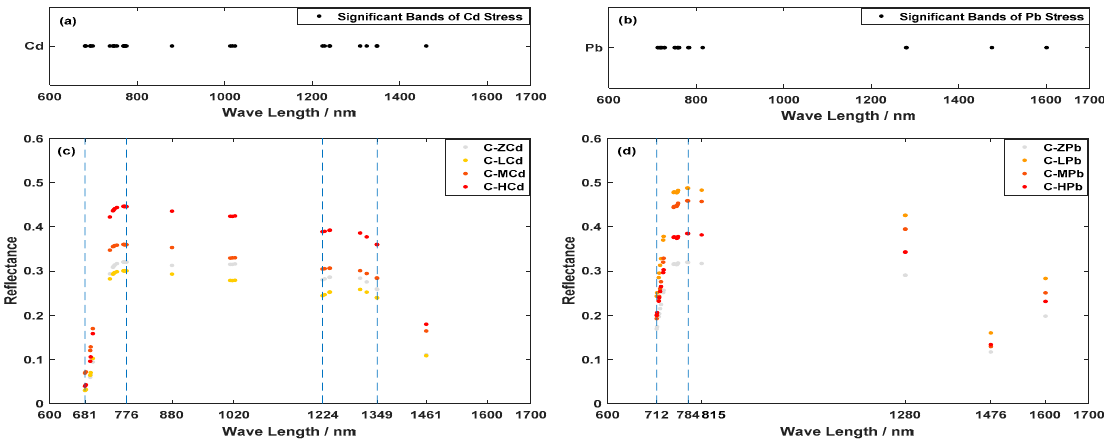
Figure 4. Ranges of spectral response for Cd-stressed ( a ), ( c ) and Pb-stressed ( b ),( d ).